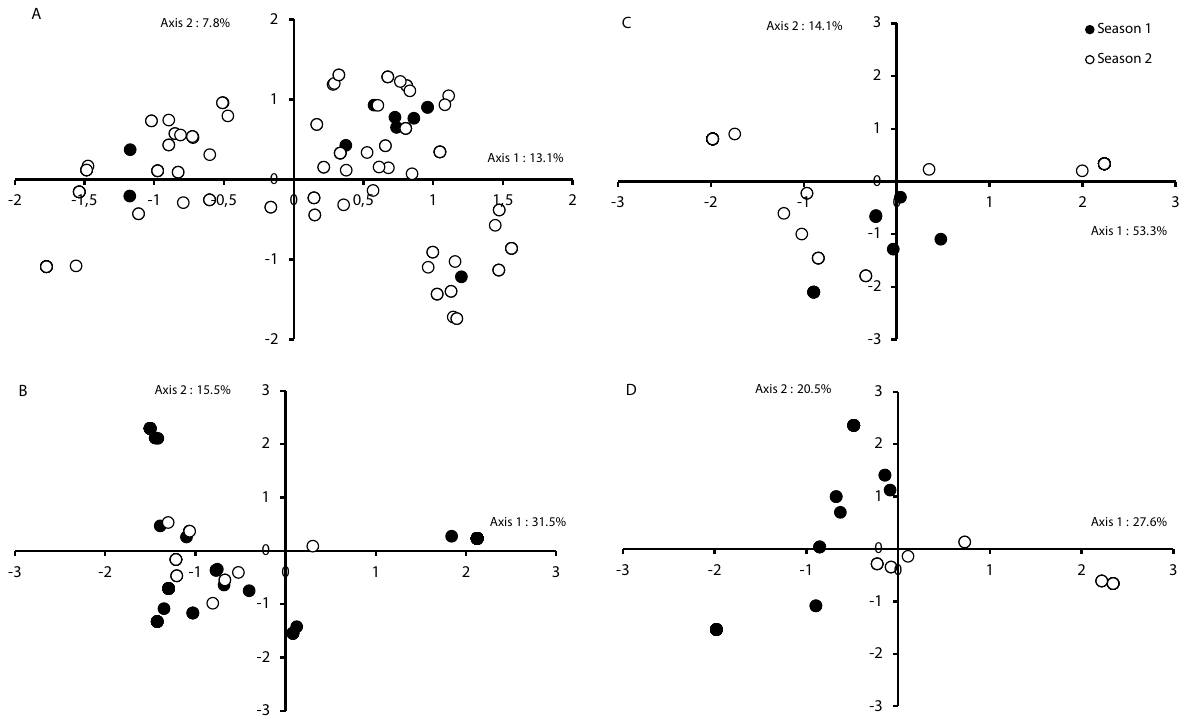
Figure 4. Principal component analysis (PCA) realized on the Ascochyta fabae sub-populations sampled during two successive cropping seasons at four locations in Tunisia. (A = Beja; B = Bizerte; C = Jendouba; D =